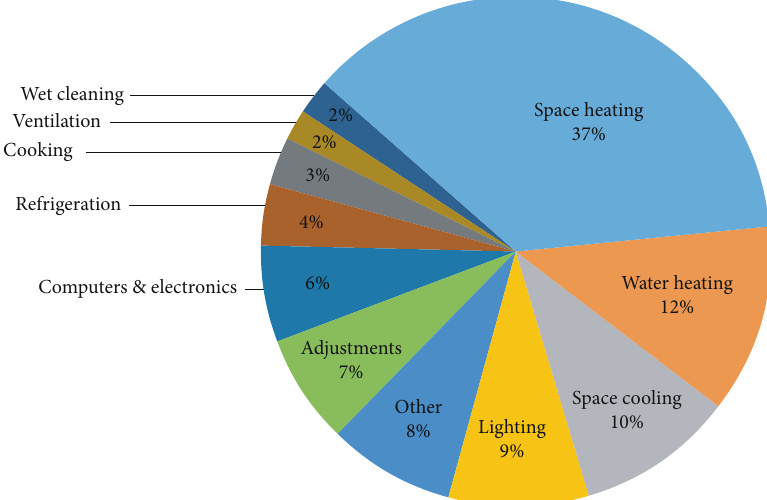
Figure 1: Building sector energy consumption in 2010 by demand